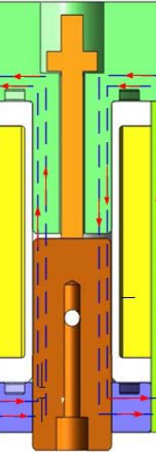
Figure 2. Magnetic circuit diagram of the digital valve.